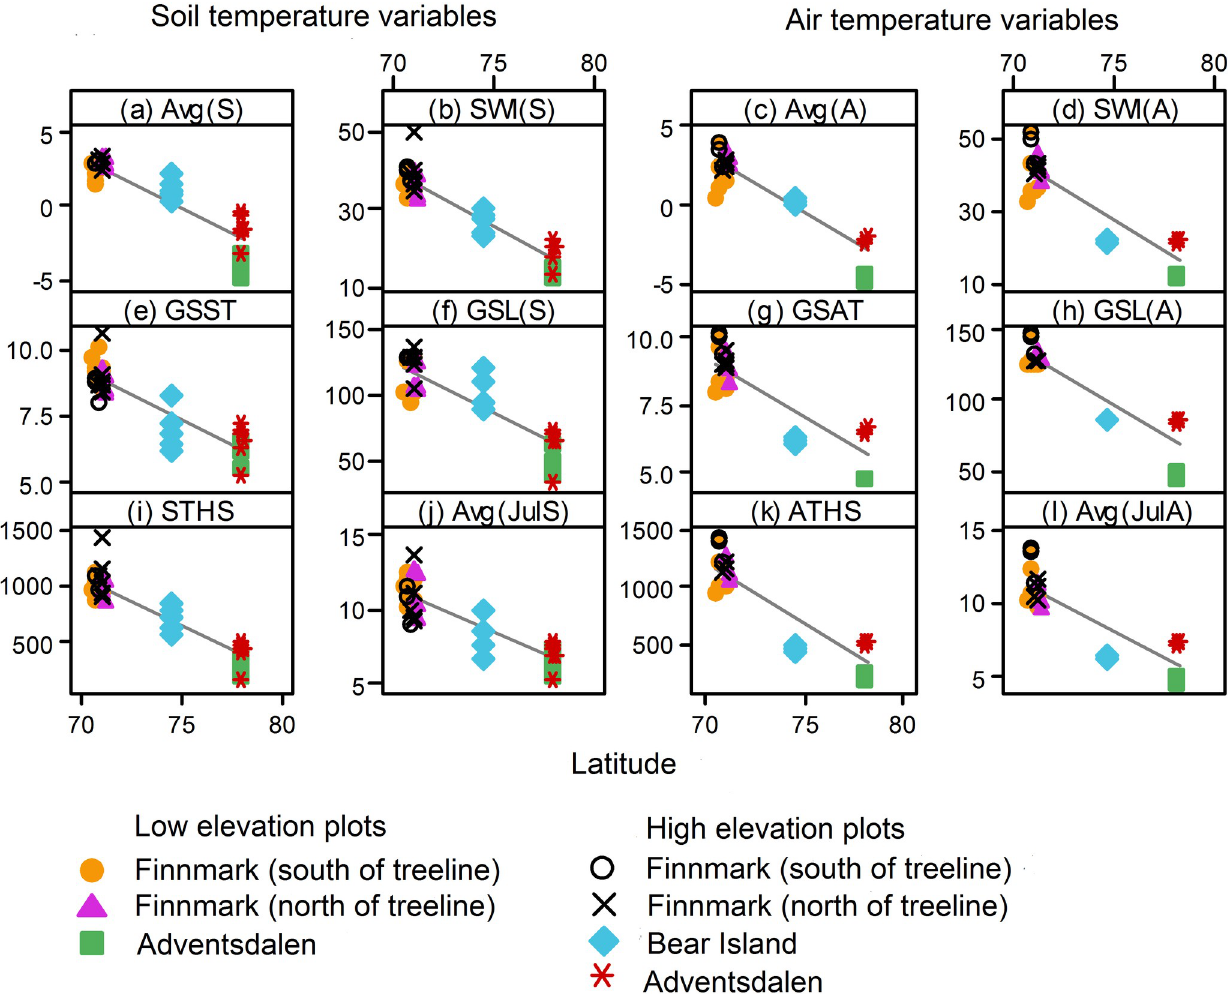
Fig 3. Trends of lowland soil temperature variables from northernmost Norway, via Bear Island to Spitsbergen. Abbreviations are according to Table 1. Regression equations are given in S1 Table.